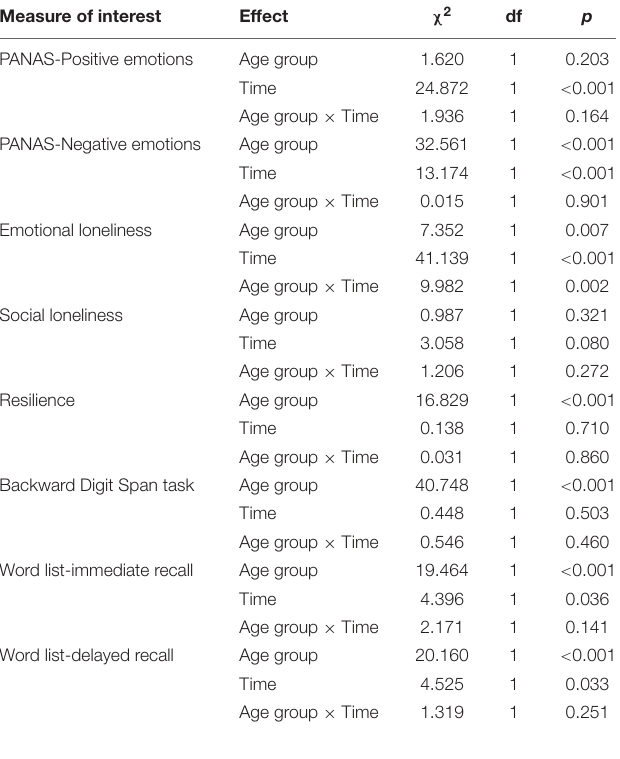
TABLE 1 | Results of the linear mixed-effects models for the measures of interest. Measure of